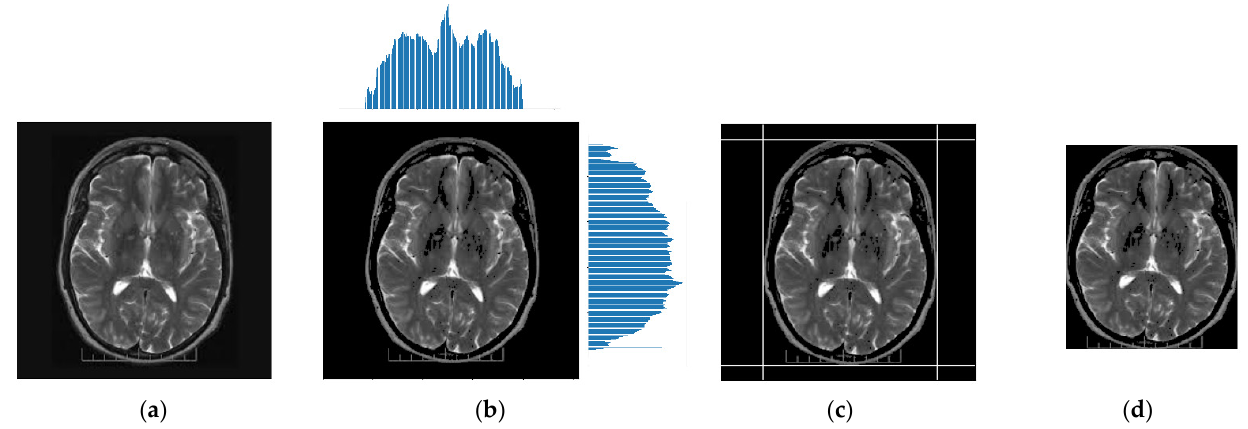
Figure 2. Example of preprocessing steps to extract the brain region image in our proposed method: ( a ) Captured brain image, ( b ) image after background removal with gray profiles in horizontal and vertical directions, ( c ) image with estimated brain ROI, and ( d ) final brain ROI image.